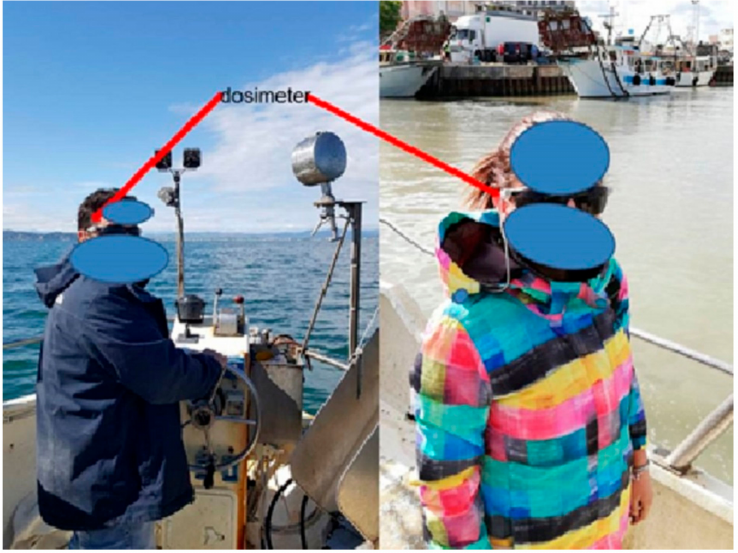
Figure 3. Personal UV dosimeters on the sunglasses of the research investigators on the